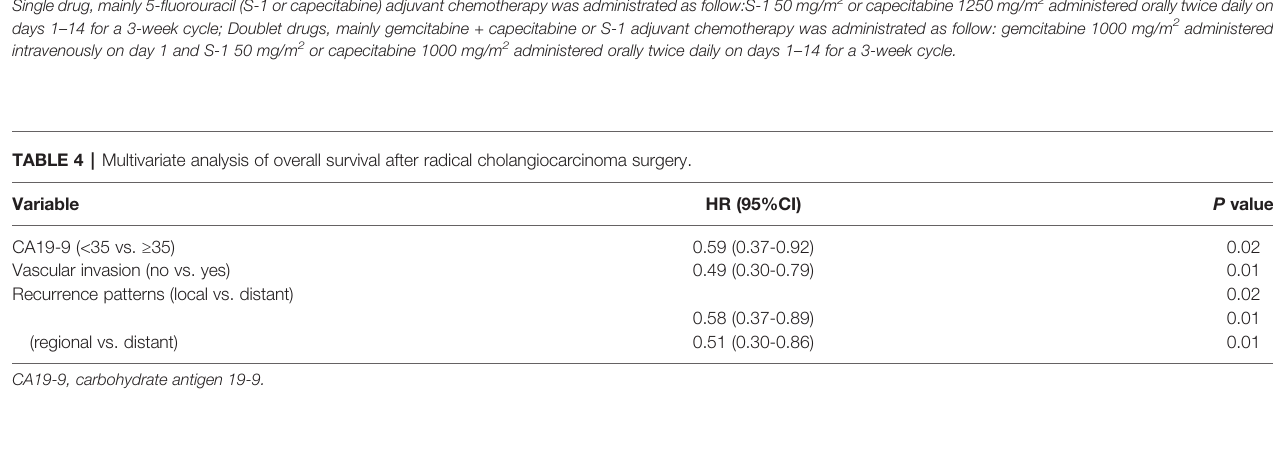
TABLE 3 | Multivariate analysis of disease-free survival after radical cholangiocarcinoma surgery. Variable HR (95%CI) P value Vascular invasion (no vs. yes)